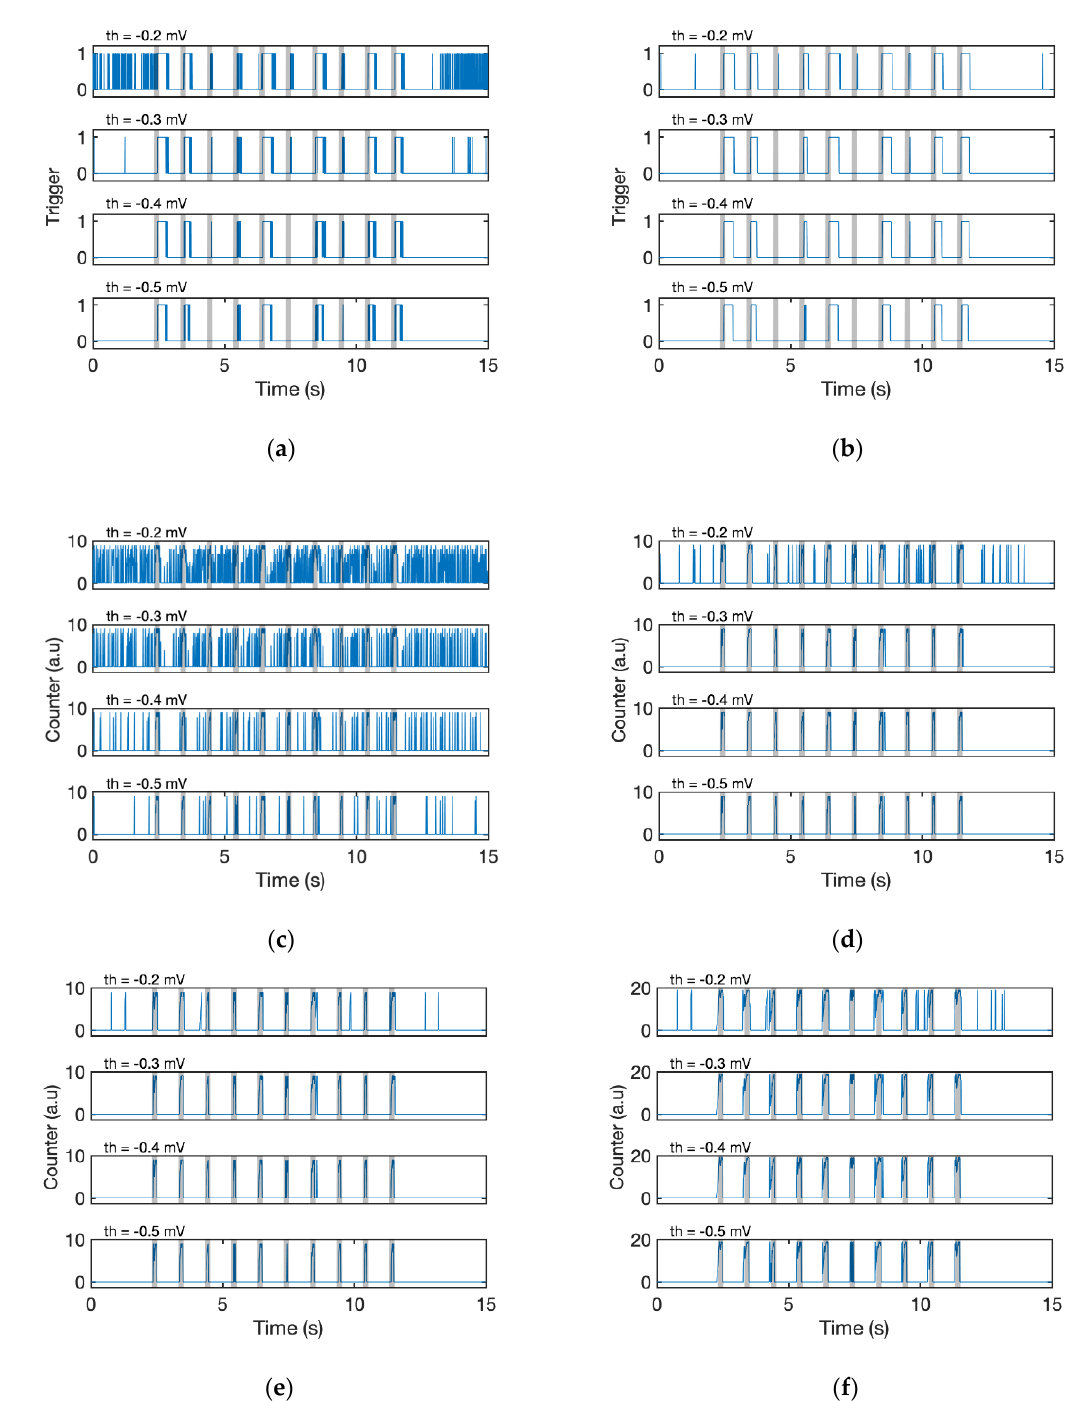
Figure 7. Results of di ff erent algorithms. The blue line indicates output of each algorithm. The original data are shown in Figure 6. ( a ) Output of the original signal with the fixed threshold method (Algorithm 3, the output is binary, 0 or 1). The results of di ff erent thresholds ( th = [ − 0.5 mV, − 0.2 mV]) are shown. Note that th in the fixed threshold is an absolute voltage, whereas th in D-counter is a relative one (see Algorithm 2 and 3) ( b ) EMA filtered signal ( α = 0.7) with the fixed threshold. ( c ) Original signal with D-Counter ( s win = 0.1 s). ( d ) EMA filtered signal ( α = 0.7) with D-Counter ( s win = 0.1 s). ( e ) EMA filtered signal ( α = 0.9) with D-Counter ( s win = 0.1 s). ( f ) EMA-filtered signal ( α = 0.9) with D-Counter ( s win = 0.2 s).